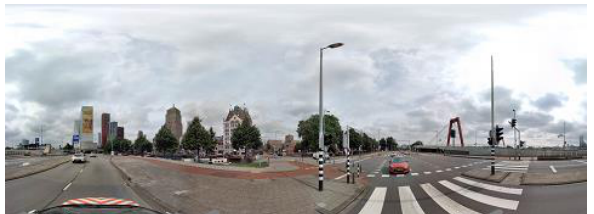
Figure 1 Mobile mapping panoramic image in equirectangular